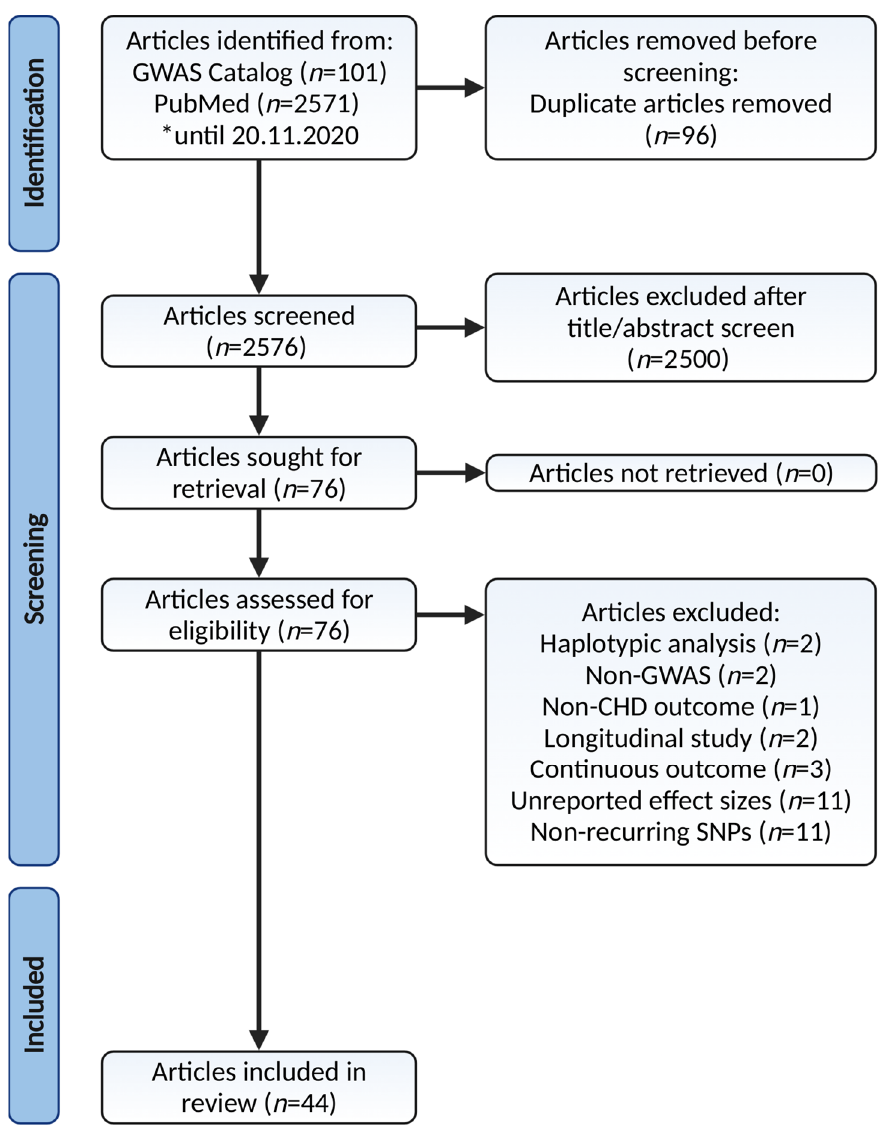
Figure 1. Flowchart of the article selection process. * The list of publications in PubMed was limited until 20 November 2020, similar to the download date of the GWAS Catalog v1.0.3.